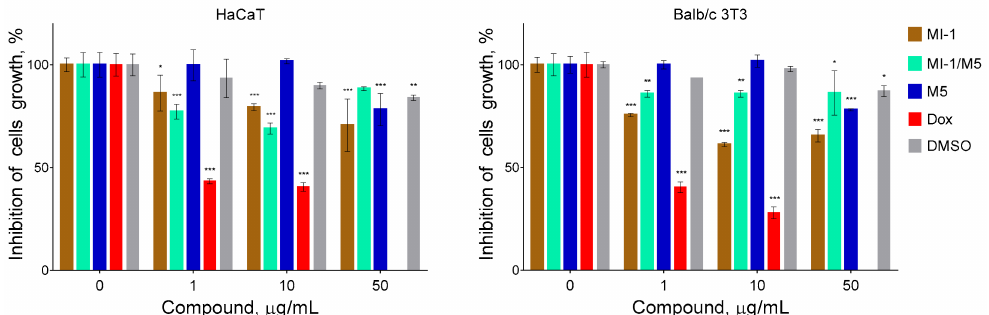
Figure 4. The cytotoxicity of maleimide derivative MI-1, its complex MI-1/M5 with polymeric carrier, free polymeric carrier poly (PEGMA- co -DMM) (M5), doxorubicin (Dox), and solvent DMSO towards pseudo-normal cells: human keratinocytes of HaCaT line and murine fibroblasts of Balb/c 3T3 line. The effect was measured by the MTT assay under 72 h cell exposure. Data are presented as the mean ± SD. * p < 0.05; ** p < 0.01; *** p < 0.001 compared with control (non-treated) cells.